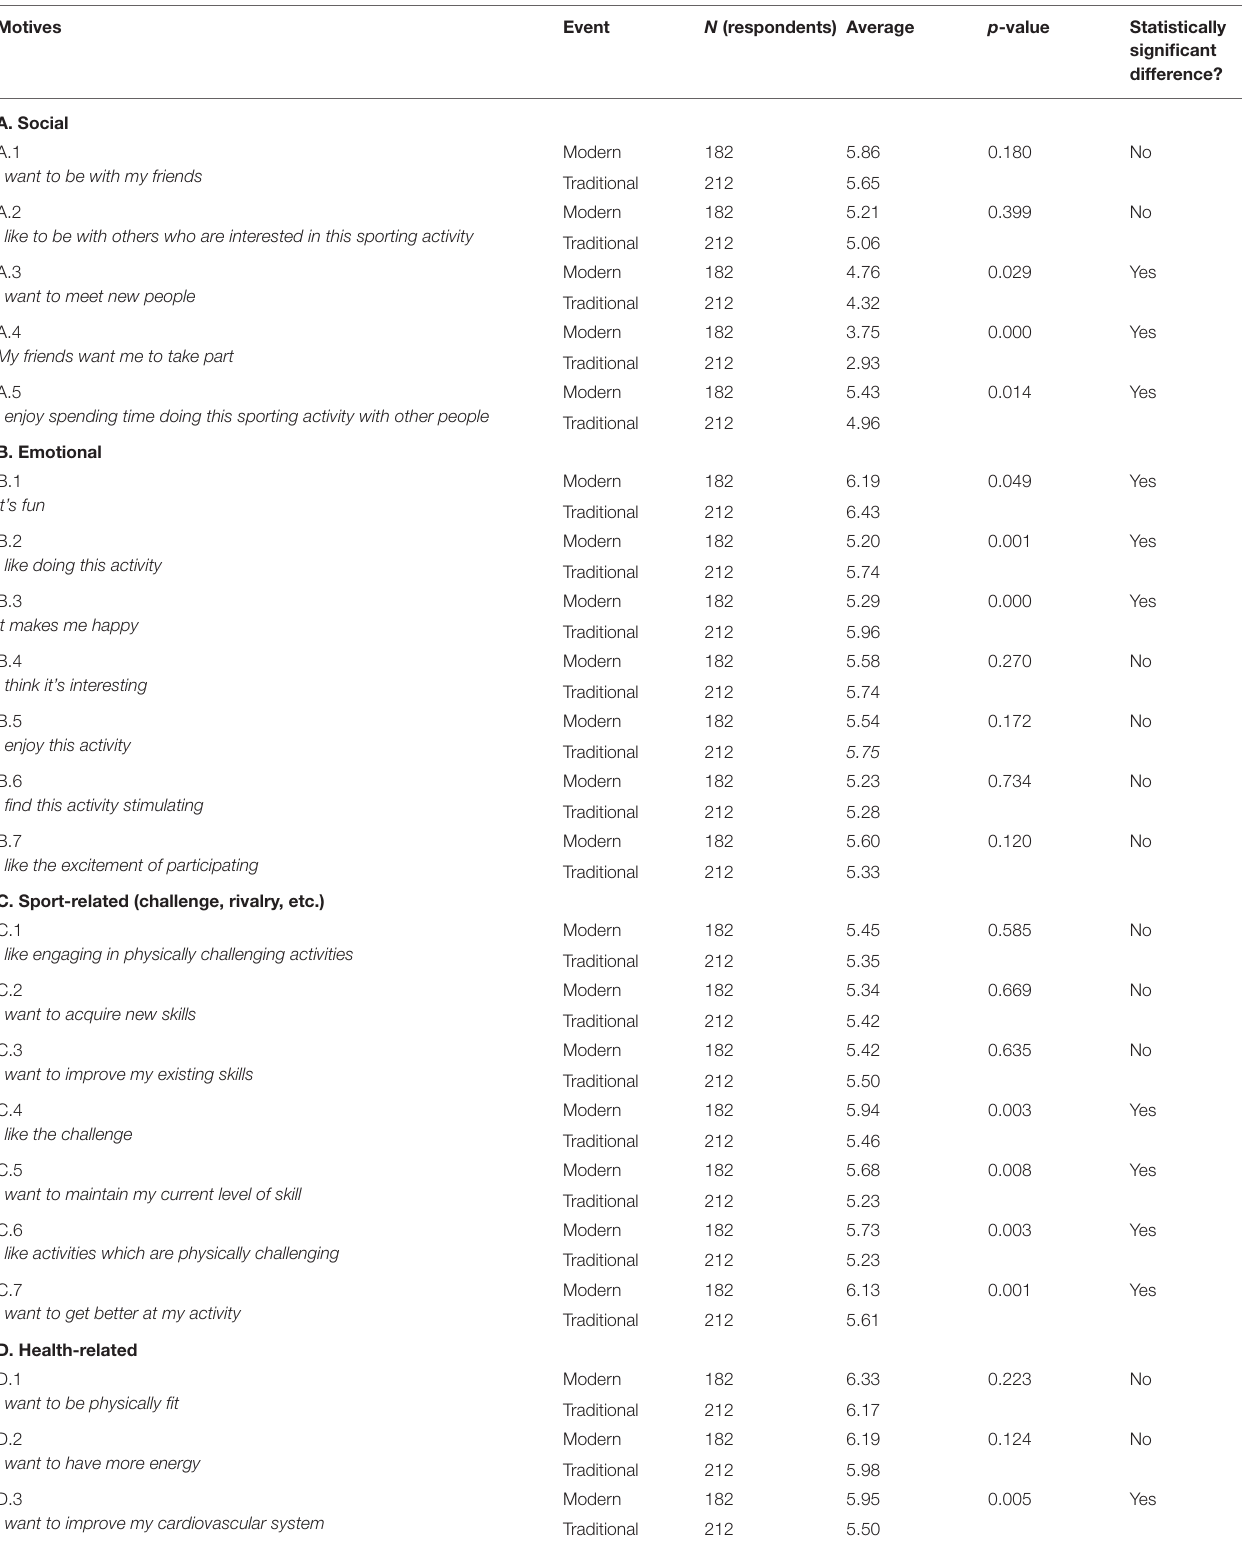
TABLE 11 | The reasons for doing sport.